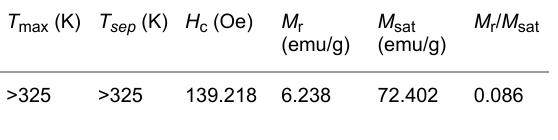
Table 1: Main magnetic parameters as derived for the USM sample by SQUID magnetometry: Maximum and separation temperatures ( T max and T sep ) as obtained by ZFC-FC magnetization curves; coercive field ( H c ), saturation magnetization ( M sat ); residual magnetization ( M r ) and residual versus saturation magnetization values ( M r / M sat ) as obtained by the hysteresis curve collected at 5